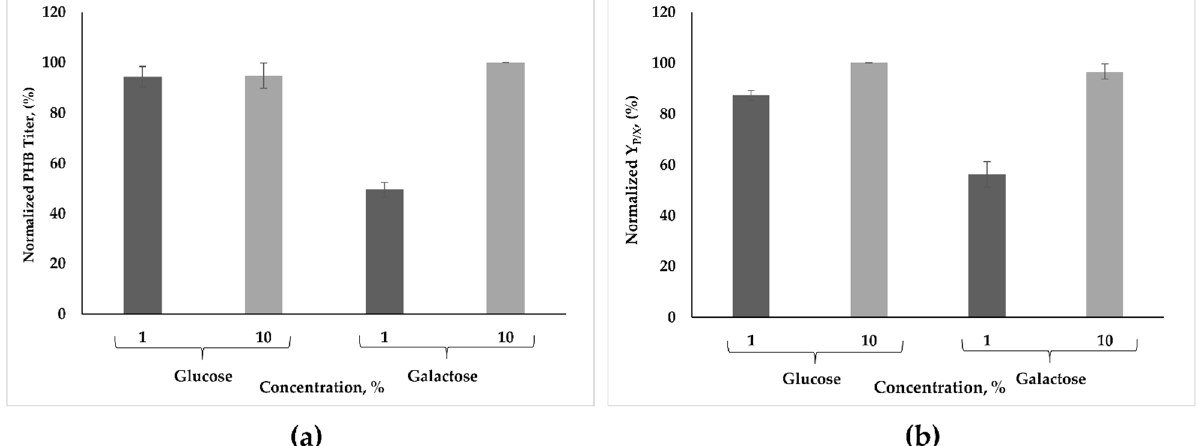
Figure 4. Effect of galactose on PHB synthesis. ( a ) Normalized amount of PHB titer (%). ( b ) Normalized Y P/X (%).